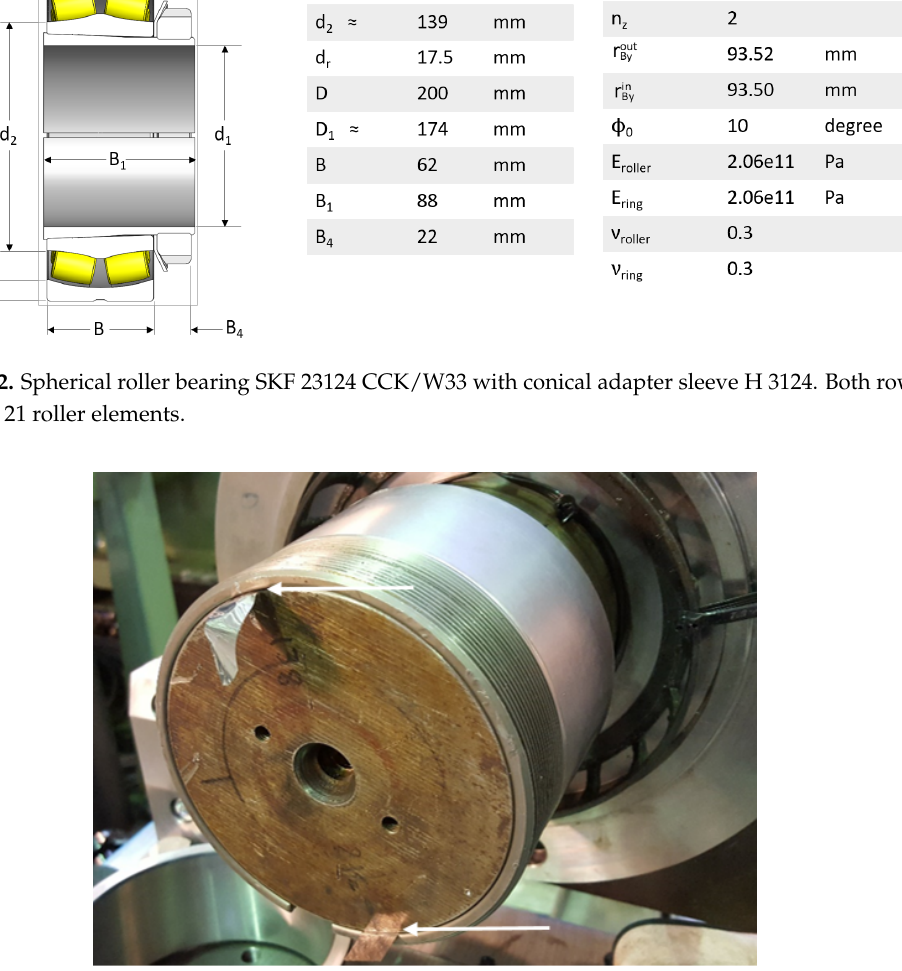
Figure 3. The bearing inner ring roundness profile was modified by inserting steel shims between the conical adapter sleeve and the rotor shaft